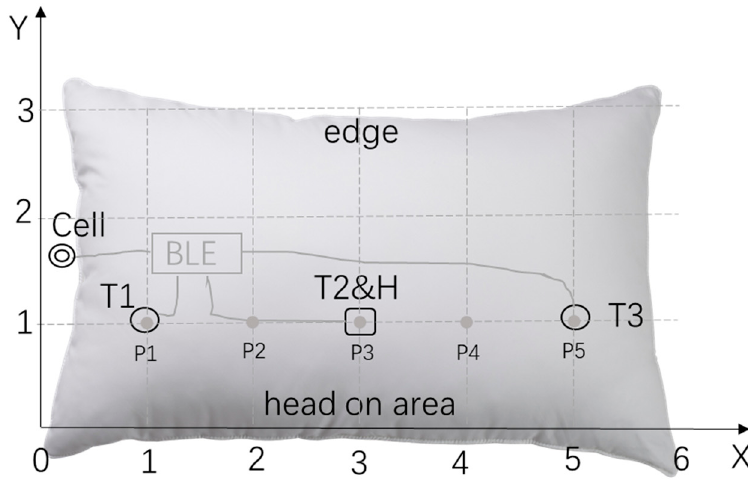
Figure 4. Physical structure of smart pillow as Cartesian Figure 4. Physical Structure of Smart Pillow as Cartesian Coordinates.